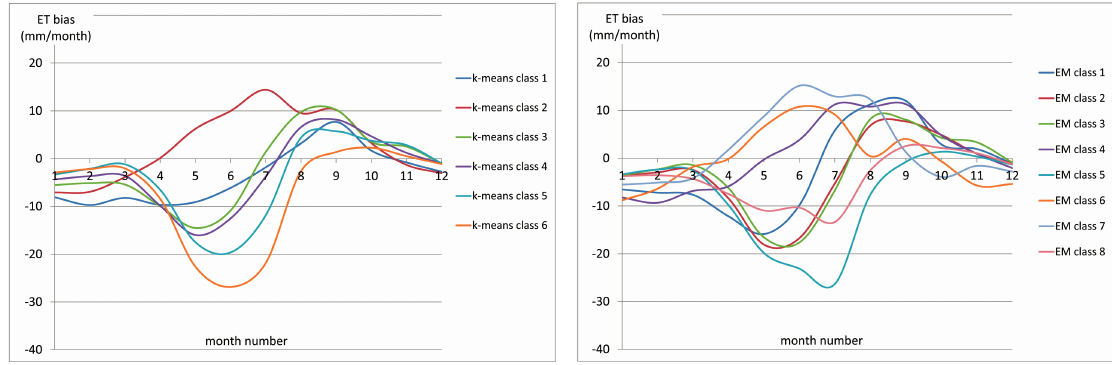
Figure 5. Bias between MSG–ET and GLDAS–ET obtained in rain–fed pixels and averaged per class, using different classifiers. ( a ) k–means; ( b ) EM; ( c ) PCA; ( d ) ROM; ( e ) all rain–fed pixels. Note: Monthly discrete values are connected to facilitate visual